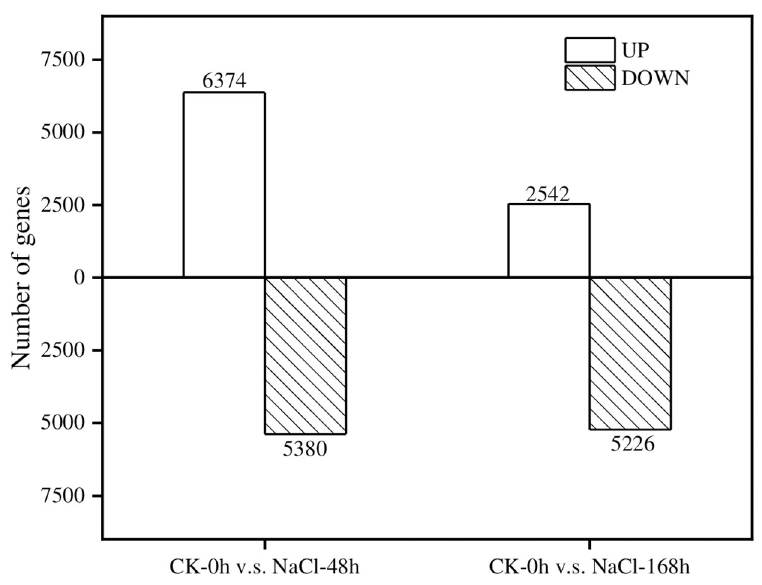
Fig 4. Analysis of DEGs. (The differentially expressed genes were up-regulated and down-regulated in the comparison groups of CK-0h v.s. NaCl-48h and CK-0h v.s.